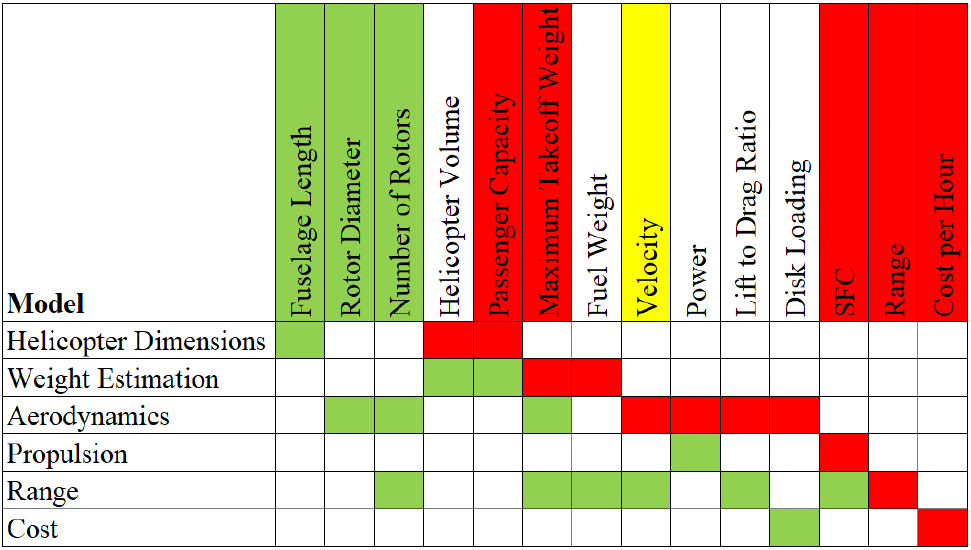
Table 2. The input/output matrix, where inputs are indicated in green and outputs in red. Addition- ally, design parameters are highlighted in green, optimization objectives in red, and constraints are in